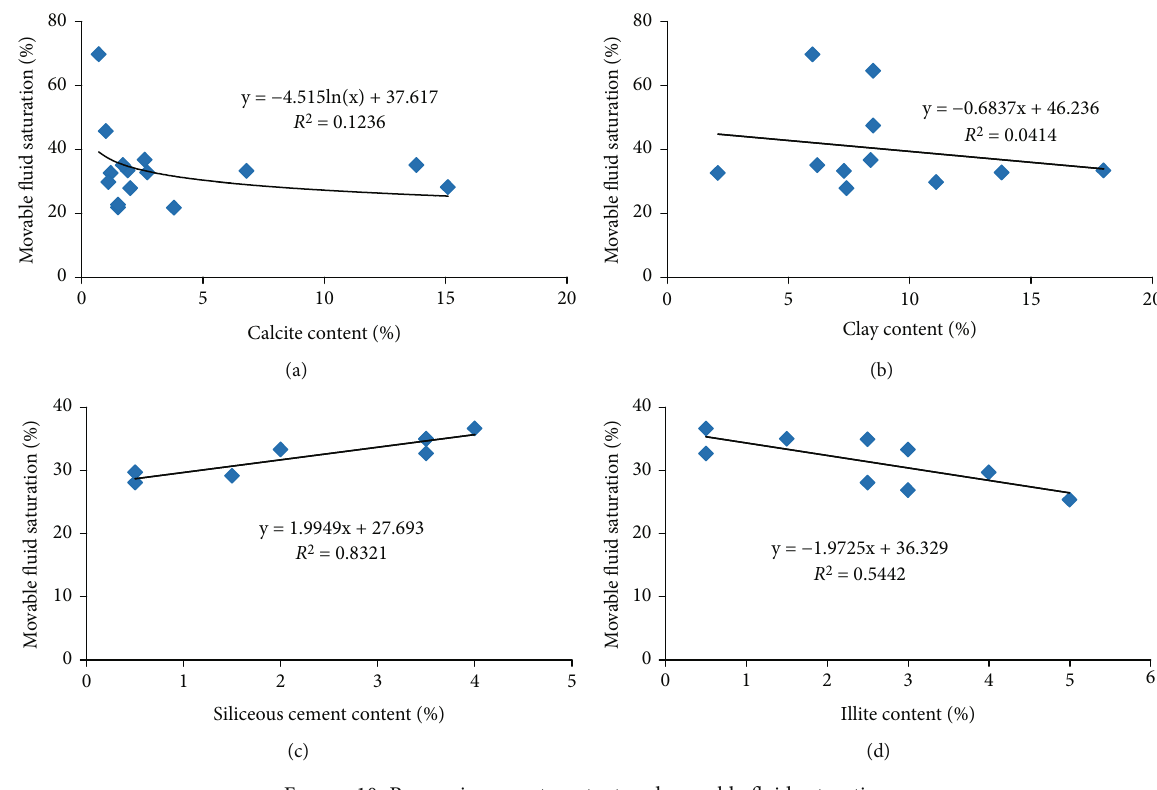
Figure 10: Reservoir cement content and movable fl uid